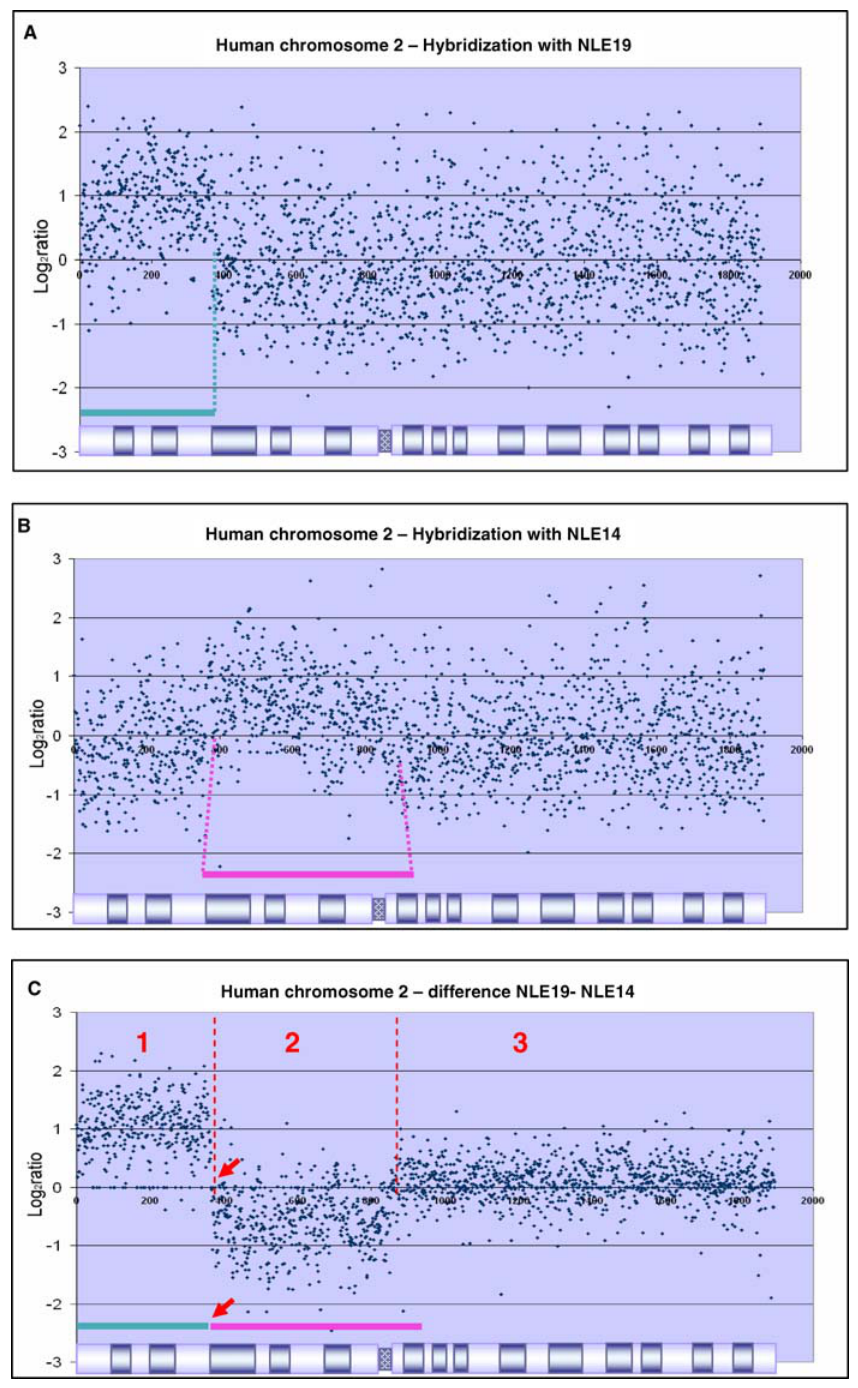
Figure 1. Identification of Break of Synteny Regions Using the Log 2 Ratio Difference Method (A and B) The plotted value of Log 2 ratio/chromosome length for human Chromosome 2 after hybridization with sorted gibbon chromosomes NLE14 and NLE19, respectively. (C) Results of the application of the difference method to the datasets in (A) and (B). After canceling out the systematic variation, it is possible to discern three different regions from left to right, one amplified (1), one deleted (2), and one at the baseline (3).